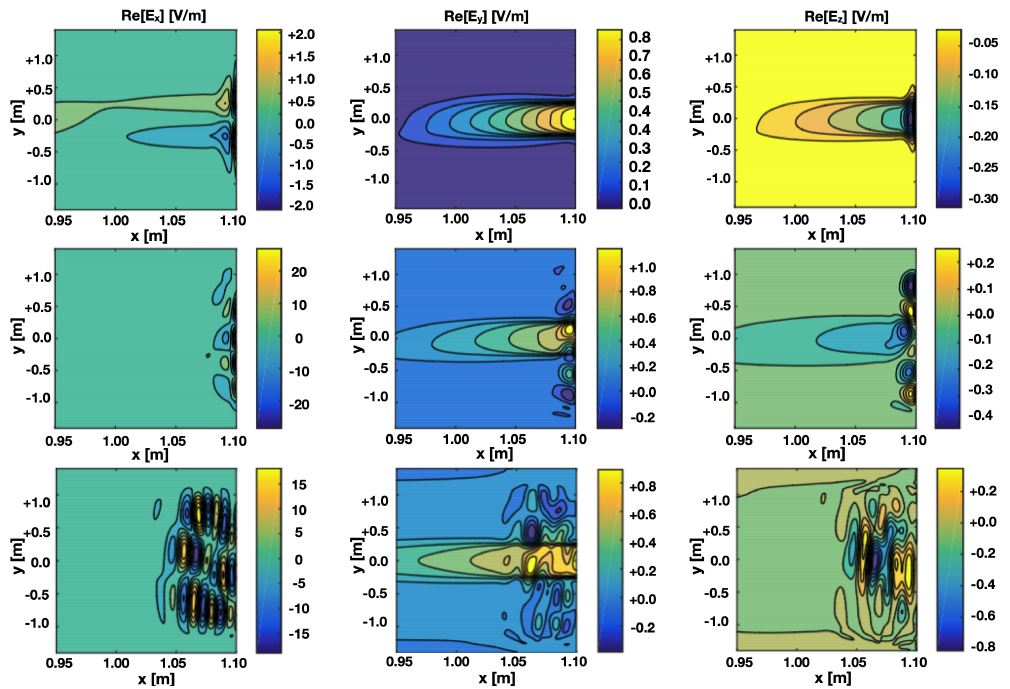
Figure 3. Real parts of the electric field components, E x (radial; left ), E y (poloidal; middle column ), and E z (toroidal; right ) for a density of 10 19 /m 3 ( top ), 5 × 10 18 /m 3 ( middle row ), and 10 18 /m 3 ( bottom ) at the last closed flux surface with a magnetic field tilt of Θ = 0.2 rad. E y = 1 V/m was imposed as “antenna” at the antenna location.